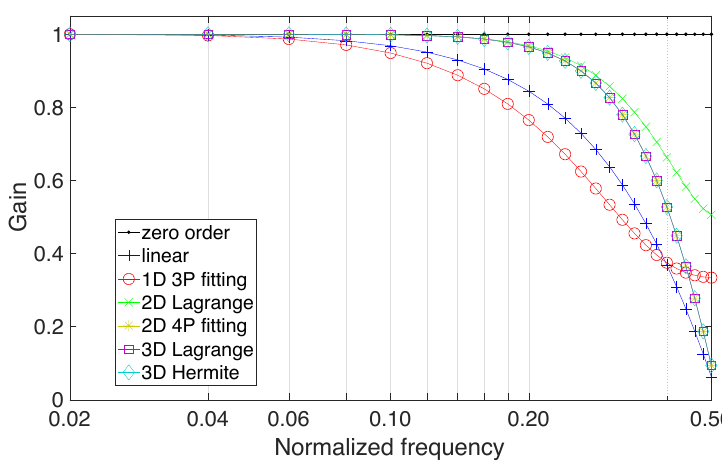
Figure 2. Frequency response of the anti-alias filters implicit in the resampling approaches based on the use of approximating polynomials.